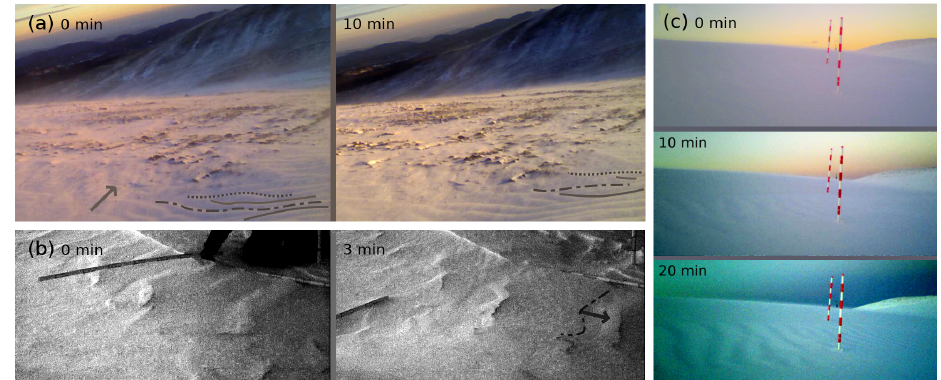
Figure 5. Time-lapse images of snow ripples on Niwot Ridge, Colorado. (a) Ripples advect from 07:28 to 07:38 on 19 November 2016 (video S1 at 1:32). (b) Sand covers the crests of advecting ripples from 17:23:33 to 17:26:33 on 18 January 2018 (video S1 at 2:06). Pole has 10cm stripes. (c) Ripples emerge from a previously flat snow-covered surface on Niwot Ridge between 18:05 and 18:25 on 27 March 2018 (video S1 at 2:23). Poles are 2m apart and have 10cm stripes. Ripples travel many wavelengths between